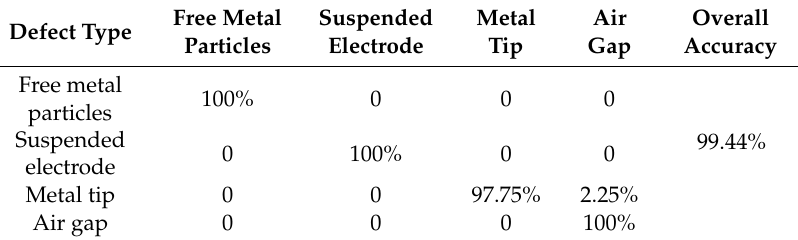
Table 5. Recognition rate of the HOG method.